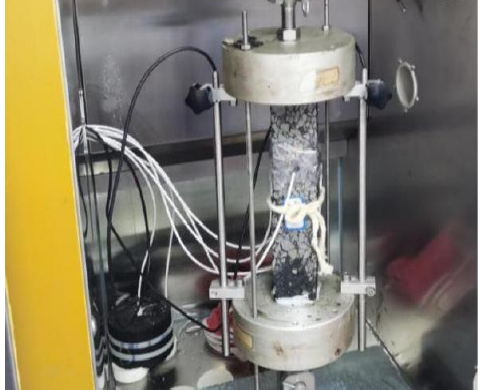
Figure 2. Test setup using UTM.